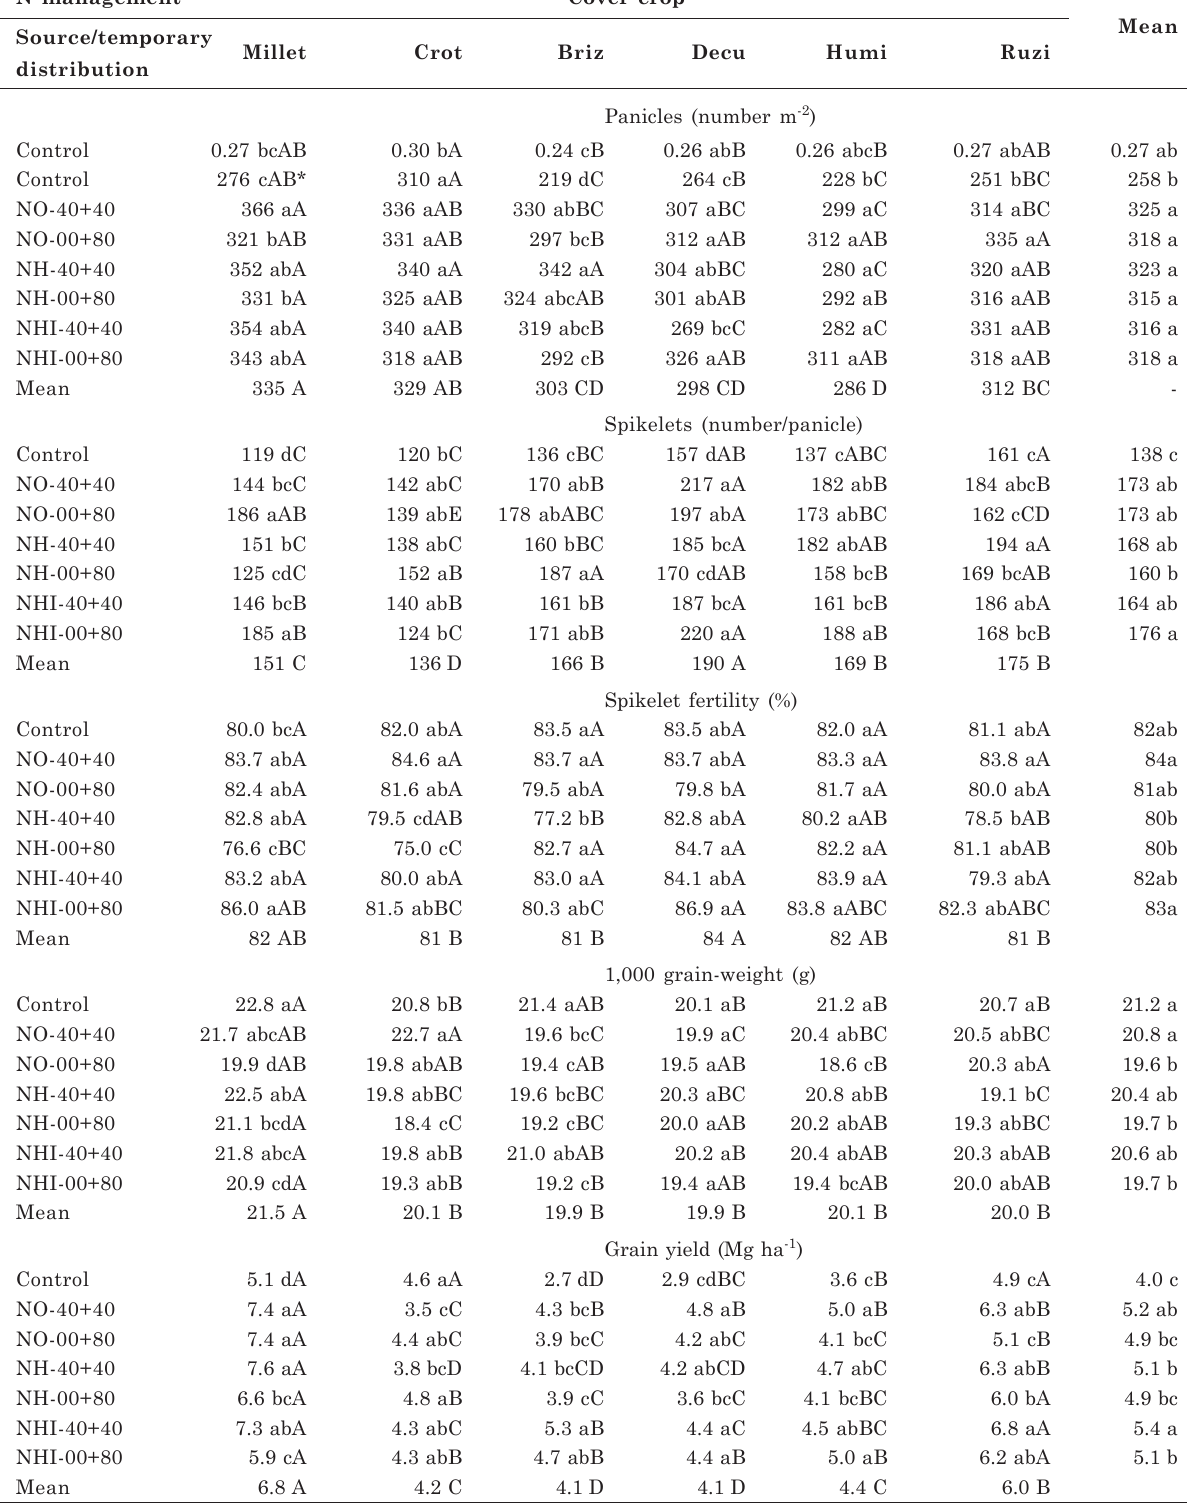
Table 4. Yield components of upland rice as affected by cover crops and nitrogen sources under no-tillage N